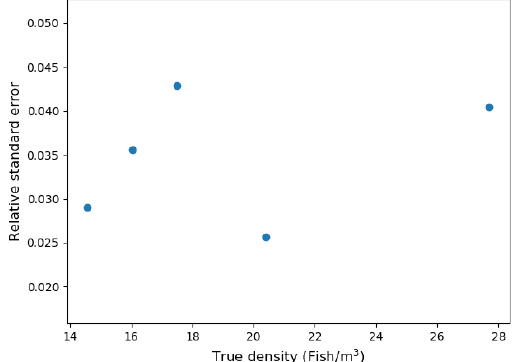
Figure 20. The regression line of estimated fish density (fish/m 3 ) at various fish densities. The shaded area represents the 95% confidence interval of the slope and the dash line with (slope = 1) would represent 100% accuracy.